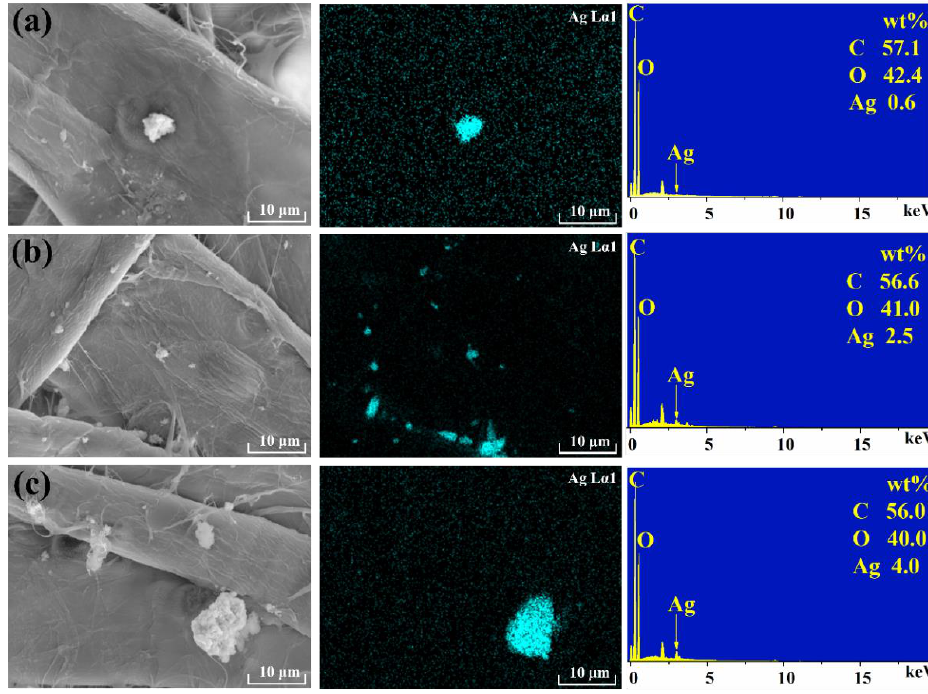
Figure 3. EDS of silver nanoparticle paper. Molar ratio of AgNO 3 : NaBH 4 = 1:4, AgNO 3 concentra- tions were 0.01 mol/L ( a ), 0.05 mol/L ( b ), 0.1 mol/L ( c ).